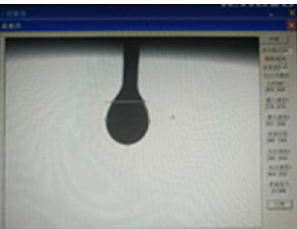
Figure 1. water surface tension